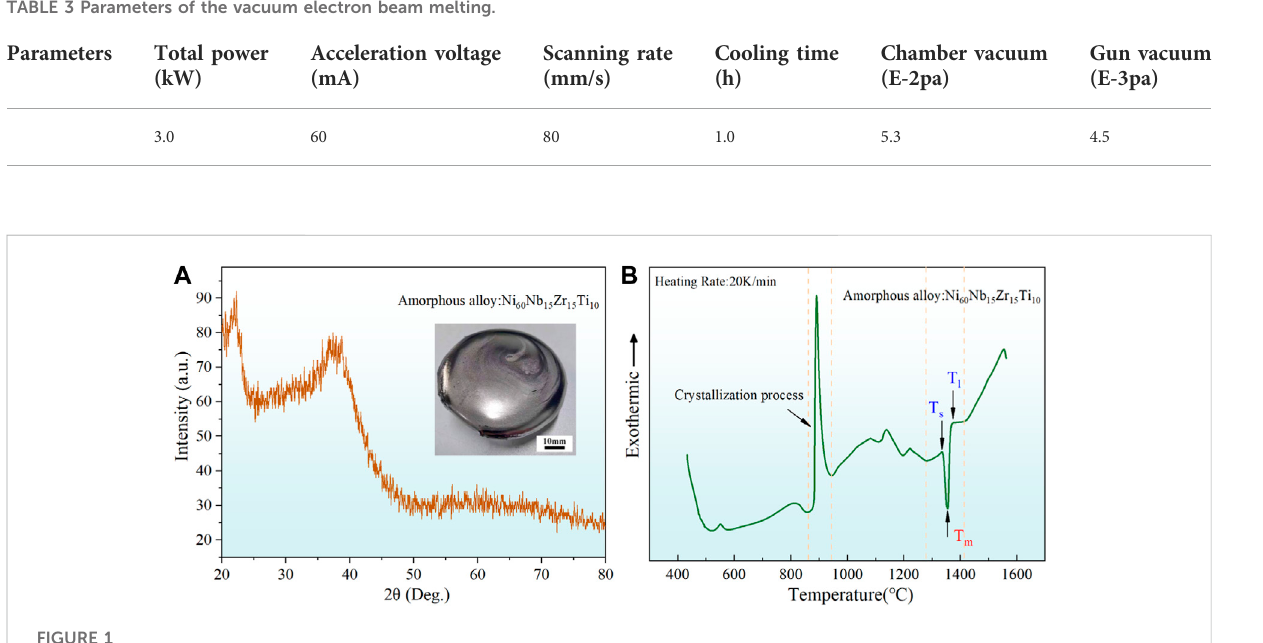
FIGURE 1 (A) XRD pattern and (B) DSC curve of the obtained amorphous